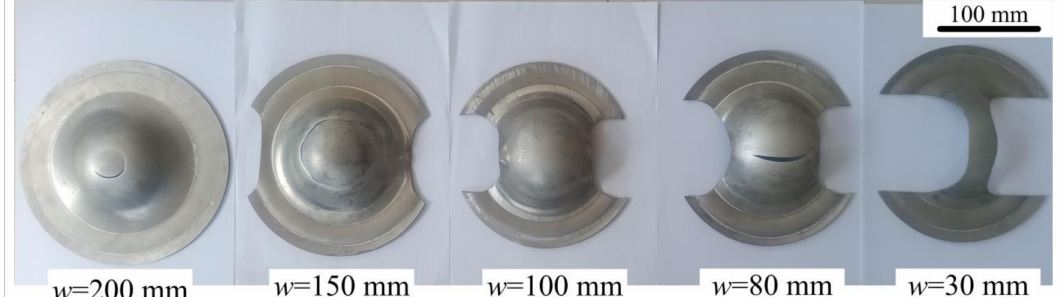
Figure 8. Isothermal forming of a limit fracture of 7075 aluminum alloy